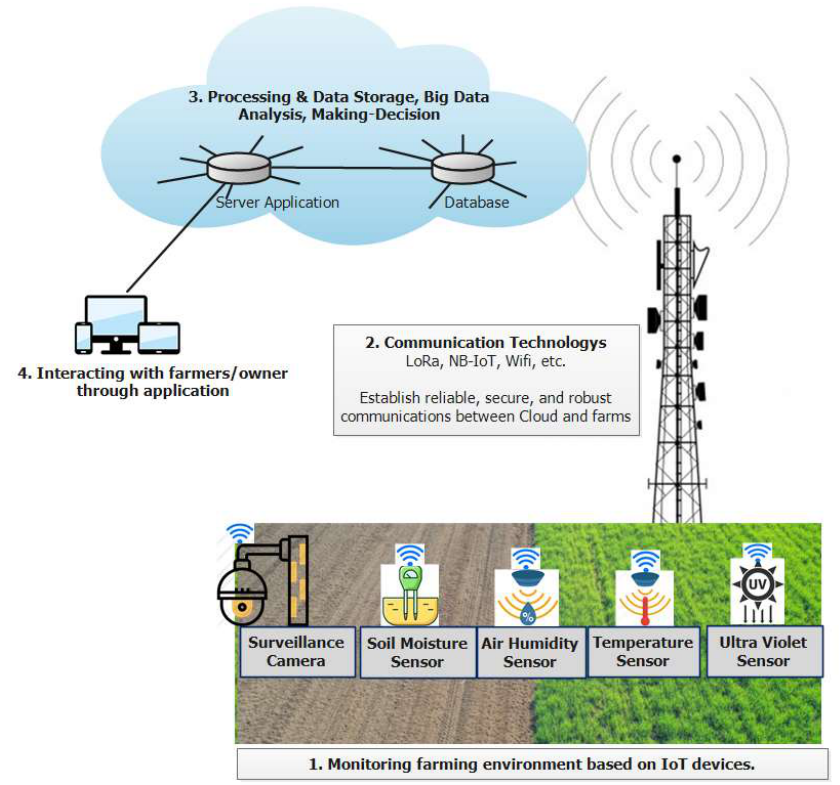
Figure 2. An illustration of IoT ecosystems’ architecture for smart agriculture.